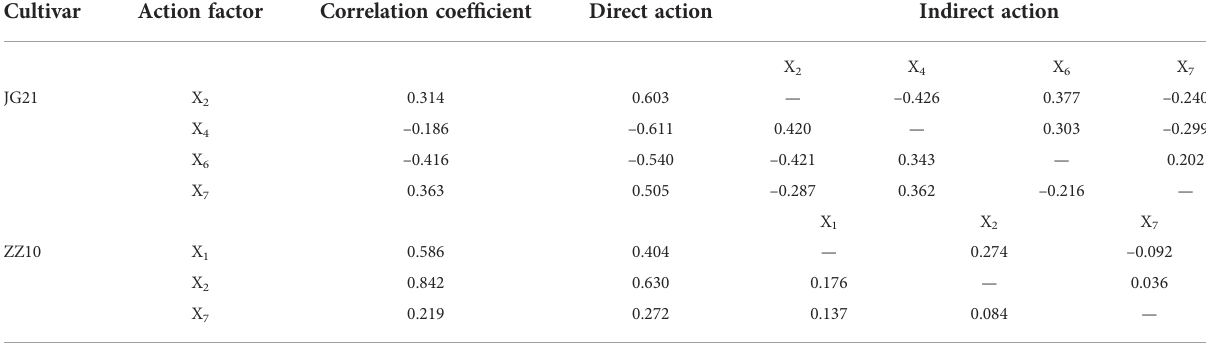
TABLE 5 Path coef fi cients of yield and sucrose metabolism-related enzymes. Cultivar